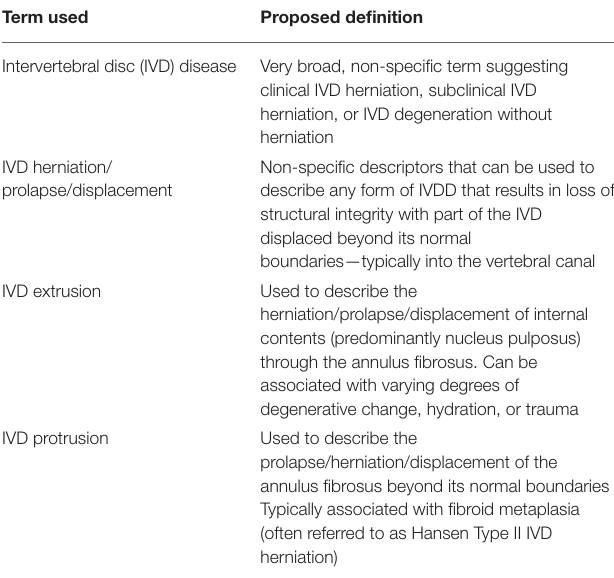
TABLE 1 | Glossary of words commonly used in the description of intervertebral disc disease and suggested definitions. Term